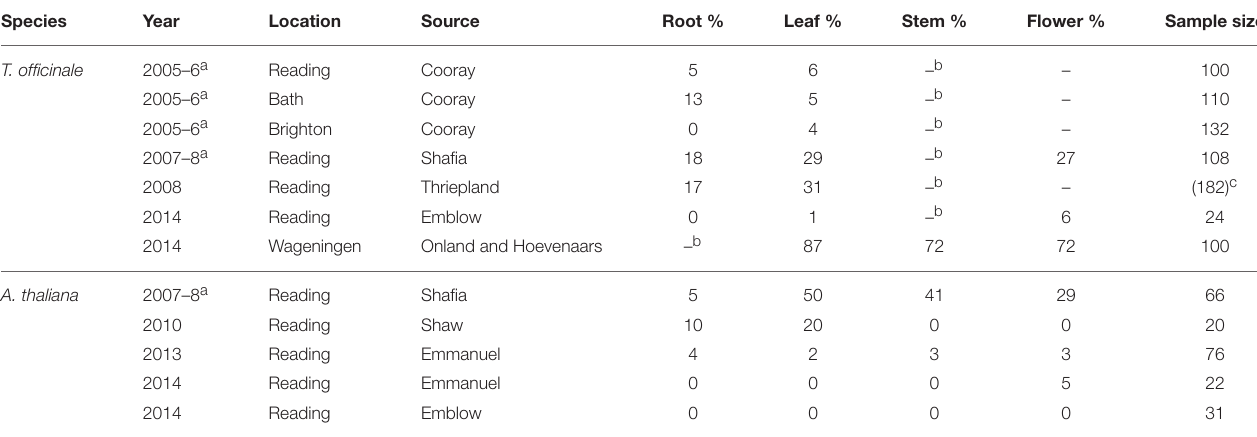
TABLE 2 | Percentage of tissue samples of wild-growing Taraxacum officinale complex and Arabidopsis thaliana from which Botrytis could be isolated after surface sterilization, at different locations and years. Species